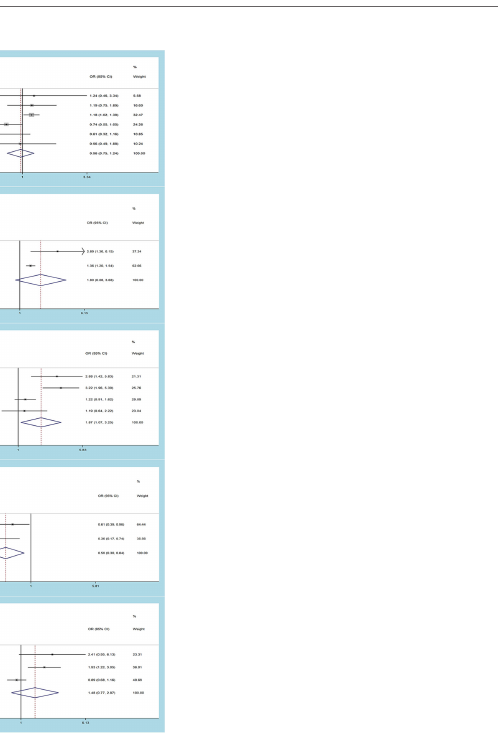
FIGURE 5 | Forest plots of the association between systemic immune-in fl ammation index and clinicopathological features in bladder cancer: (A) age (old vs. young); (B) sex (male vs. female); (C) concomitant carcinoma in situ (yes vs. no); (D) lymph node involvement (yes vs. no); (E) lymphovascular invasion (yes vs. no); (F) tumor size ( ≥ 3 cm vs. <3 cm); (G) tumor number (unifocal vs. multifocal); (H) tumor differentiation (poor vs. well); (I) tumor stage [muscle-invasive bladder cancer (MIBC): ≥ T3 vs. <T3; (J) tumor stage non-muscle-invasive bladder cancer (NMIBC): T1 vs.